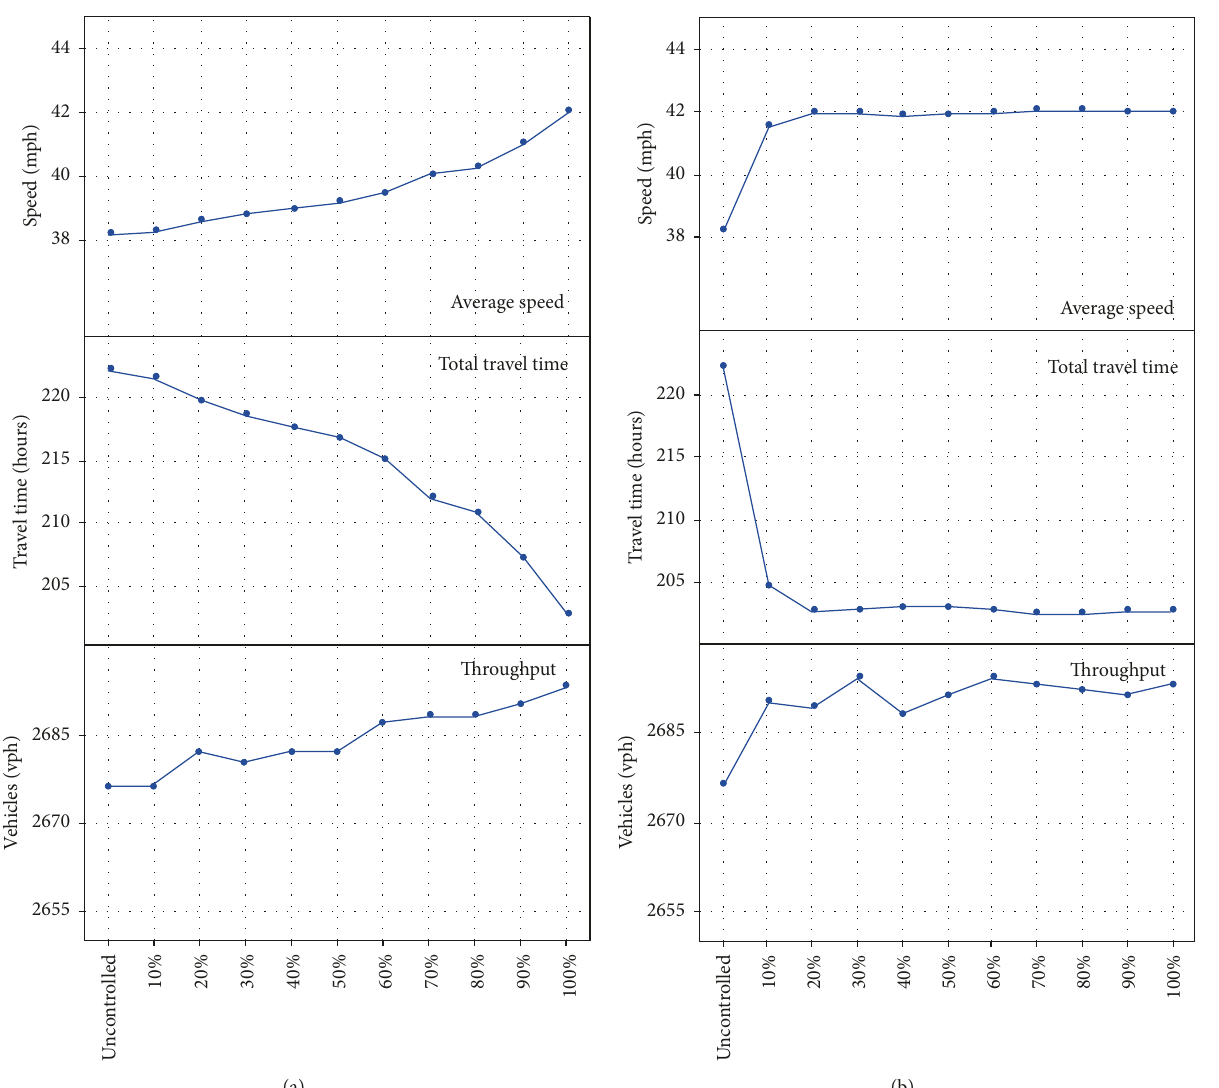
Figure 11: Network performance versus C/AV market penetration with different speed control